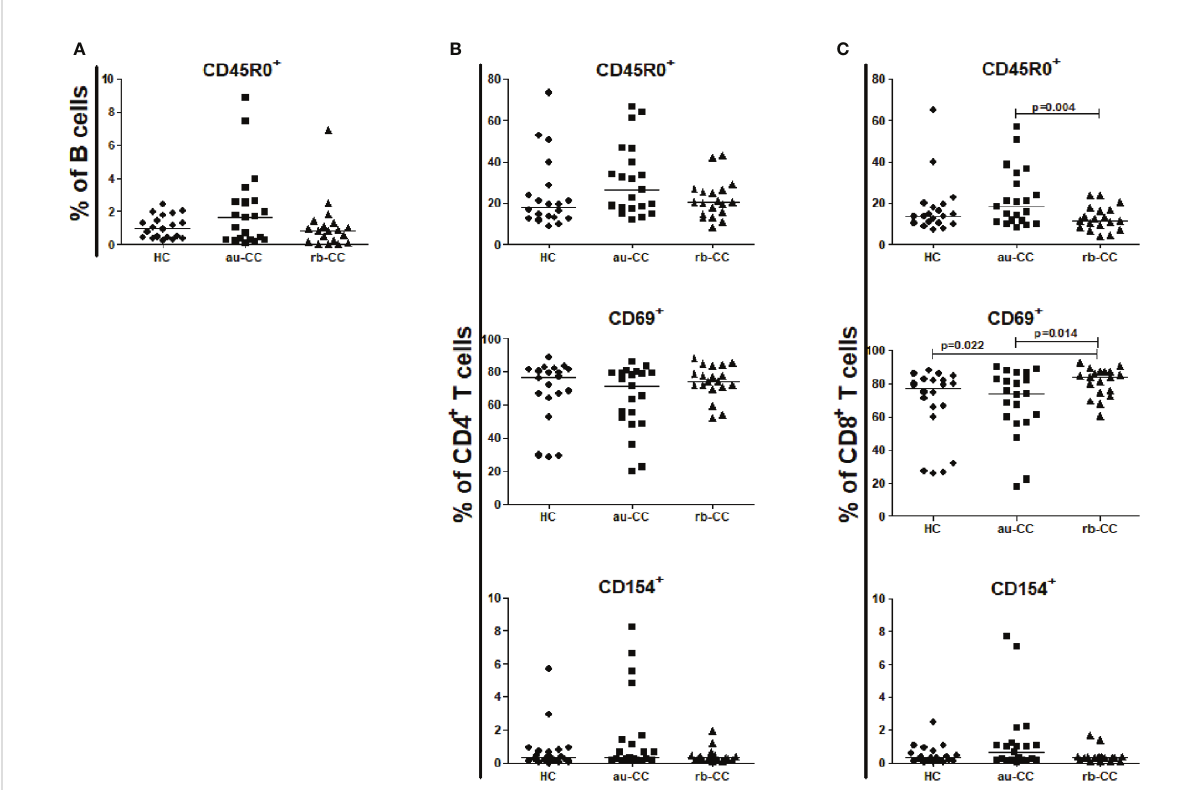
FIGURE 6 Frequencies of mucosal activated and memory subpopulations of B lymphocytes (A) , CD4+ T helper cells (B) and CD8+ cytotoxic T cells (C) in collagenous colitis. Analysis performed with fl ow cytometry. Statistically signi fi cant differences are p<0.01, statistical trends are p<0.05. au, active/untreated; CC, collagenous colitis; HC, healthy controls; rb, remission/budesonide. CD69 and CD154 are activation markers and CD45R0 memory